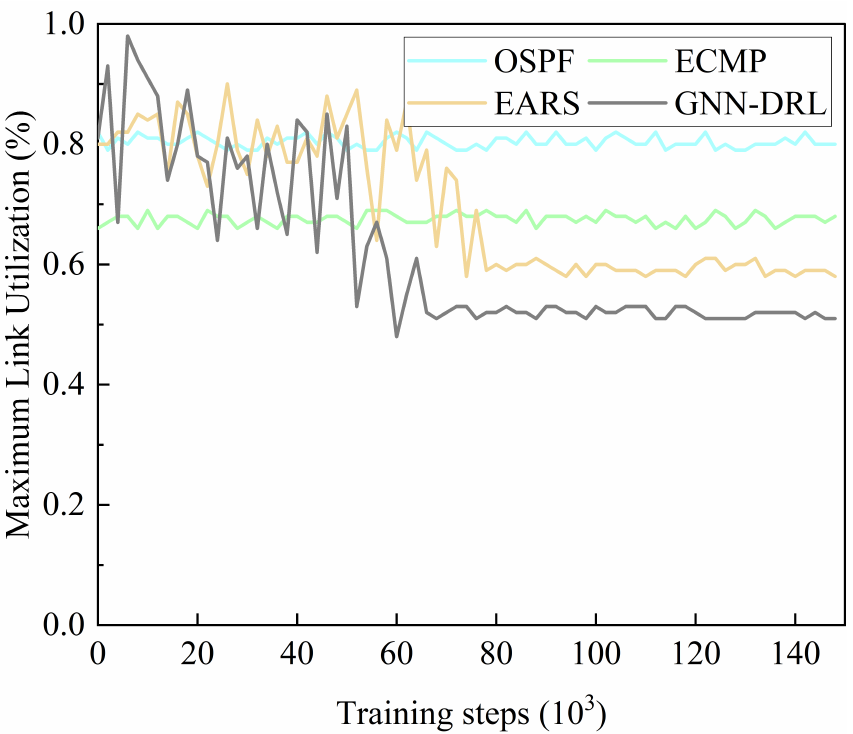
Figure 8. Optimization effect of maximum link utilization under 120 Mbps traffic load.